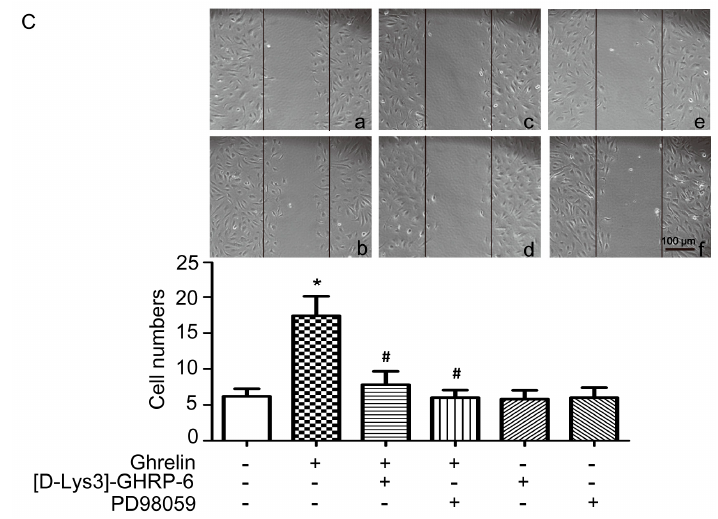
Figure 5. Ghrelin stimulates tube formation and migration of EPCs through the ERK dependent manner. ( A ) Wild type mice EPCs were pre-treated with 100 µ M [ D -Lys3]-GHRP-6 or PD98059 for 30 min, followed by incubating with 10 − 8 M ghrelin or N.S. for 15 min. The level of phosphorylated ERK or GAPDH was determined by western blotting analysis. ( B ) Tube-formation assay of EPC capillary morphogenesis after ghrelin treatment. In vitro tube formation of EPCs pre-treated with [ D -Lys3]-GHRP-6 or PD98059 was performed by cultured on Matrigel with ghrelin or N.S. treatment and cultured for 6 h, magnification, × 100. The extent of tube formation was determined by counting the tubes in five randomly chosen, low-power fields. ( C ) EPCs pre-treated with [ D -Lys3]-GHRP-6 or PD98059 were scratch-wounded and migrating cells were counted after 8 h with ghrelin or N.S. treatment, magnification, × 100. a, EPCs + N.S.; b, EPCs + 10 − 8 M ghrelin; c, EPCs + 10 − 8 M ghrelin + 100 µ M [ D -Lys3]-GHRP-6; d, EPCs + 10 − 8 M ghrelin + 100 µ M PD98059; e, EPCs + 100 µ M [ D -Lys3]-GHRP-6; f, EPCs + 100 µ M PD98059. Data are expressed as mean ± SD from three independent experiments, each performed in triplicate, * denotes p < 0.05 compared with EPCs without treatment, # denotes p < 0.05 compared with EPCs with ghrelin administration.